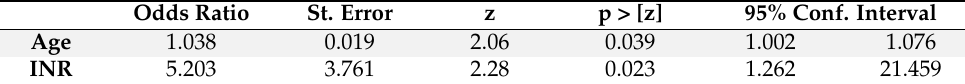
0.171 ( 1 ) Abbreviations: INR = international normalized ratio; n.v. = normal values. ( 2 ) Data are presented as number of patients count and %. Abbreviations: PLT: platelets; INR = International Normalized Ratio. Stepwise logistic regression analysis about clotting factors, adjusted for age and type